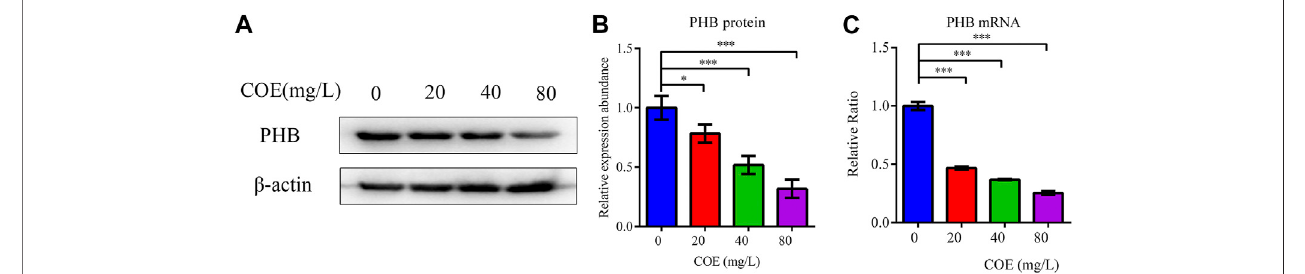
FIGURE 2 | Effect of the ethyl acetate extract of Celastrus orbiculatus (COE) on PHB mRNA (A) and protein expression (B) .